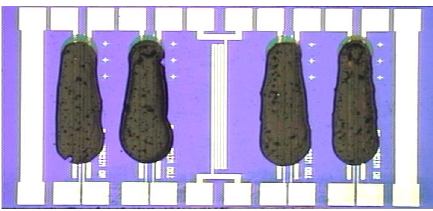
Figure 2. Chemiresistor array developed at Sandia National Laboratories with four conductive polymer films deposited onto a microfabricated circuit. A temperature sensor (middle) and heating elements (ends) are also integrated. The heater to heater distance is about 7